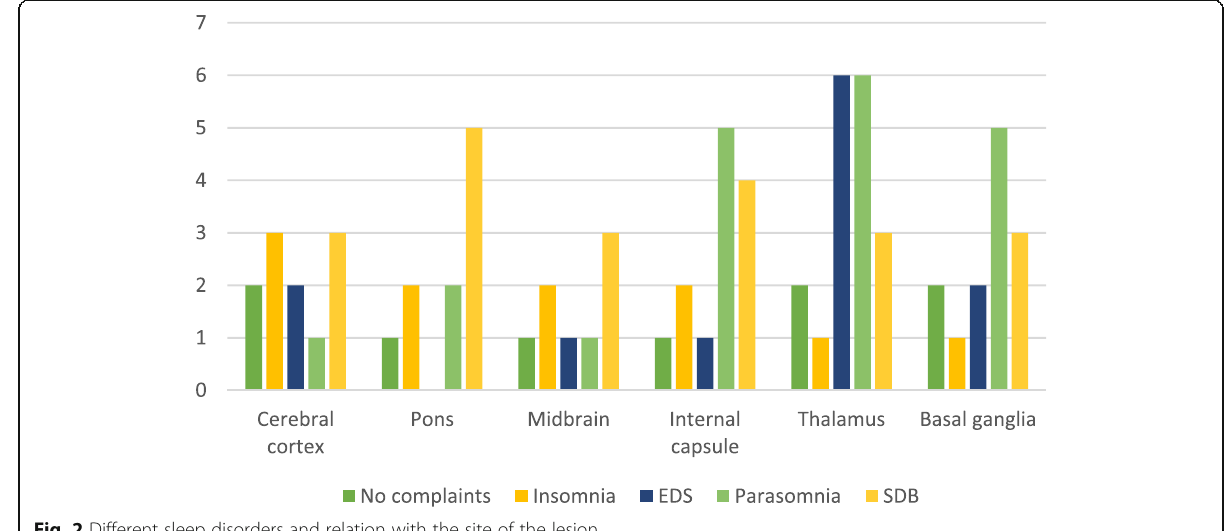
Fig. 2 Different sleep disorders and relation with the site of the